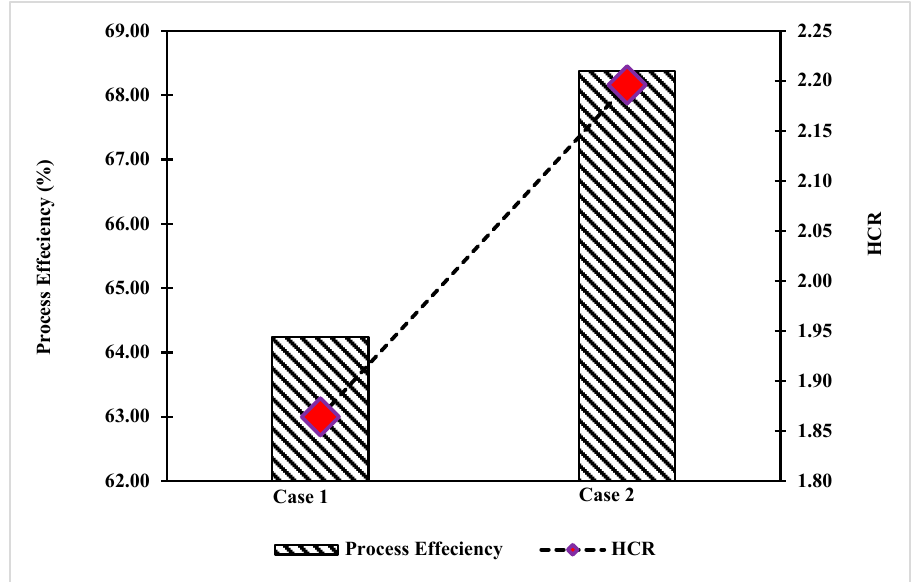
Figure 3. Comparison of process efficiency and hydrogen to carbon monoxide ratio for case 1 and case 2.